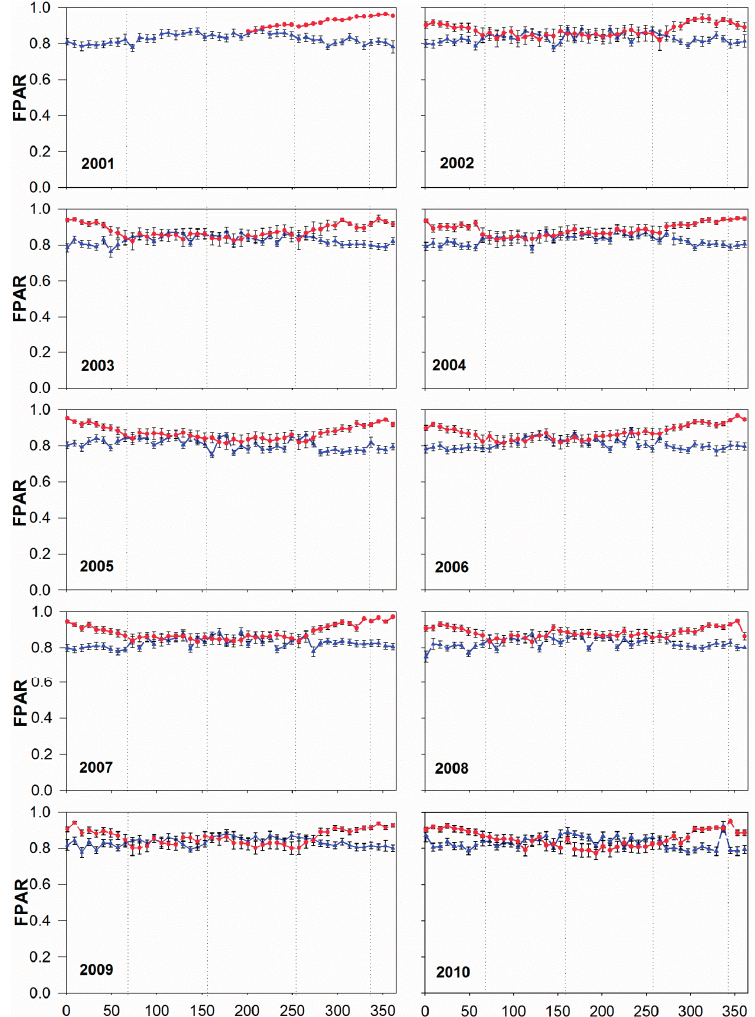
Figure 2. Comparison between the measured flux-tower FPAR and MOD15A2 FPAR from 2001 to 2010 (points represent means  SE). Blue lines represent MODIS FPAR, red lines represent tower FPAR and the dashed lines are the dividing line of the season: spring